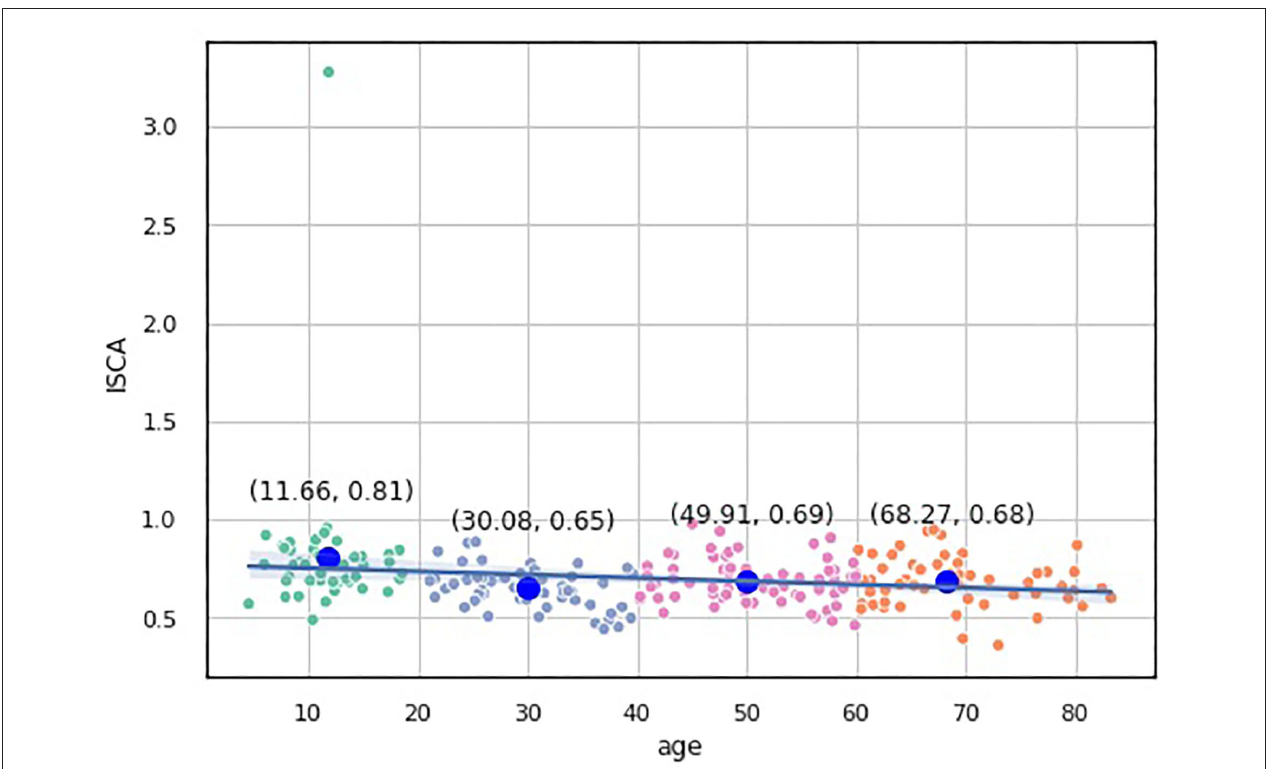
FIGURE 7 | Over-the-age distribution of ISCA